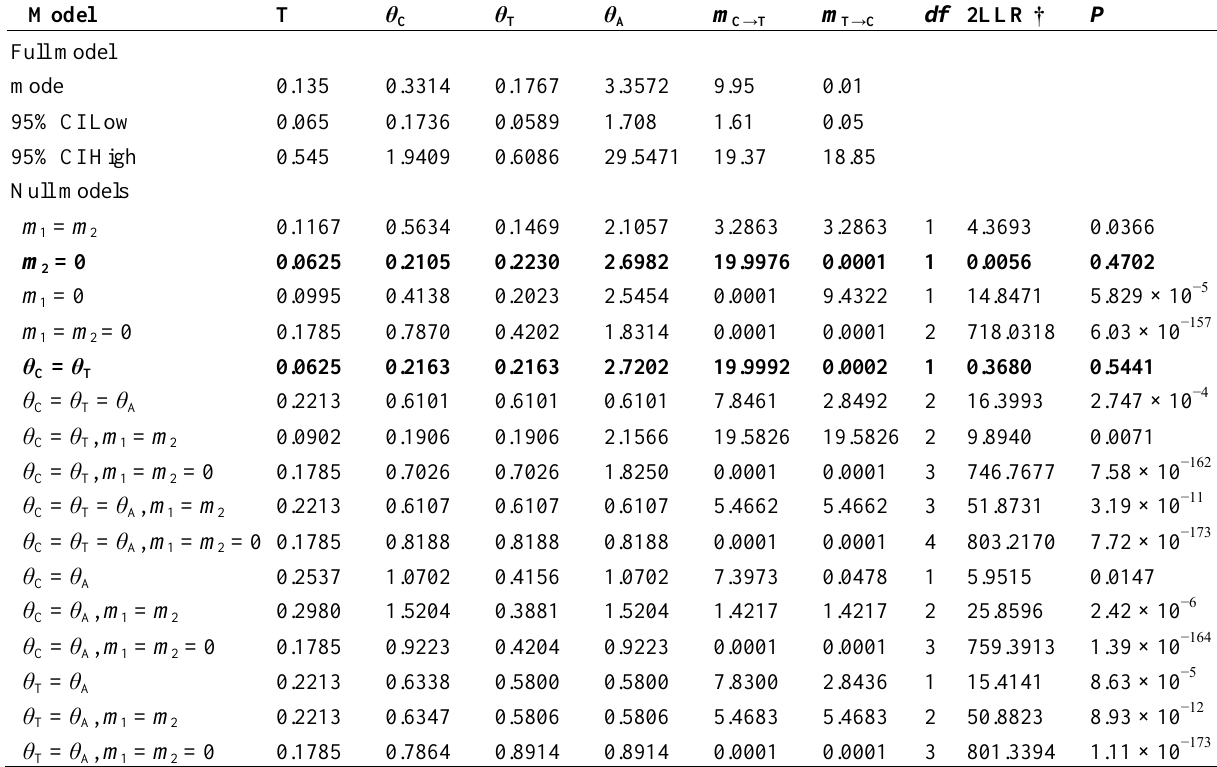
Table 4. Log-likelihood nested model tests by the full model ( θ where m = m and m = m ). Statistical nonsignificance (not rejecting the null model) 1 C→T 2 T→C is indicated in